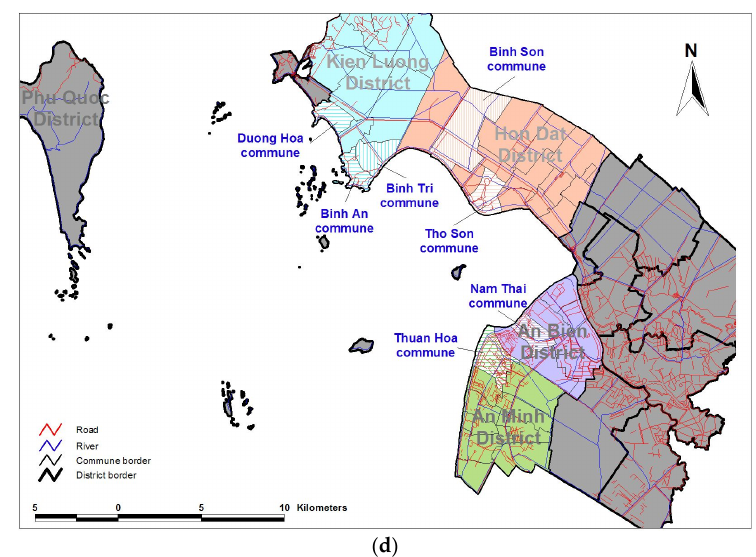
Figure 1. ( a ) Map of Vietnam showing provinces where research took place; ( b ) Dien Bien Province; ( c ) Kon Tum Province; ( d ) Kien Giang Province. Communes labelled in blue were sites of REDD+ projects and our research.